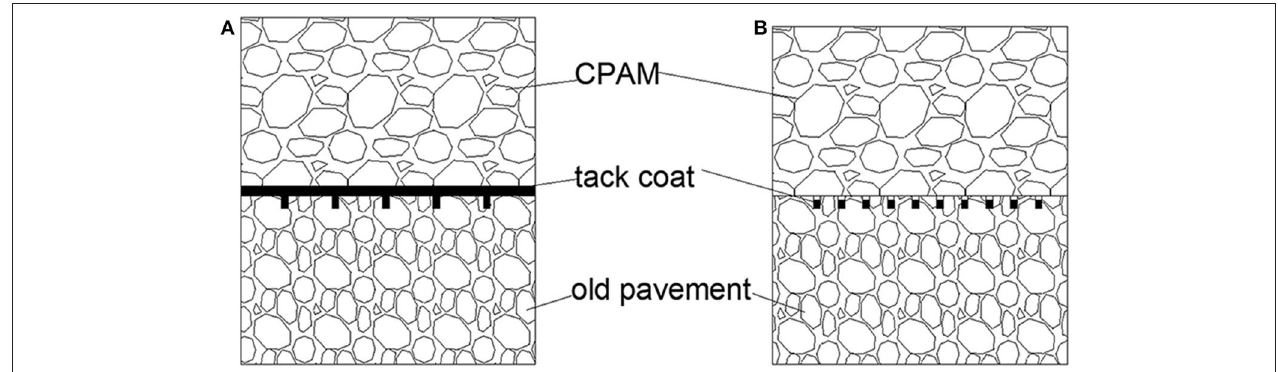
FIGURE 12 | Competitive relationship of the tack coat between the groove and the interface.